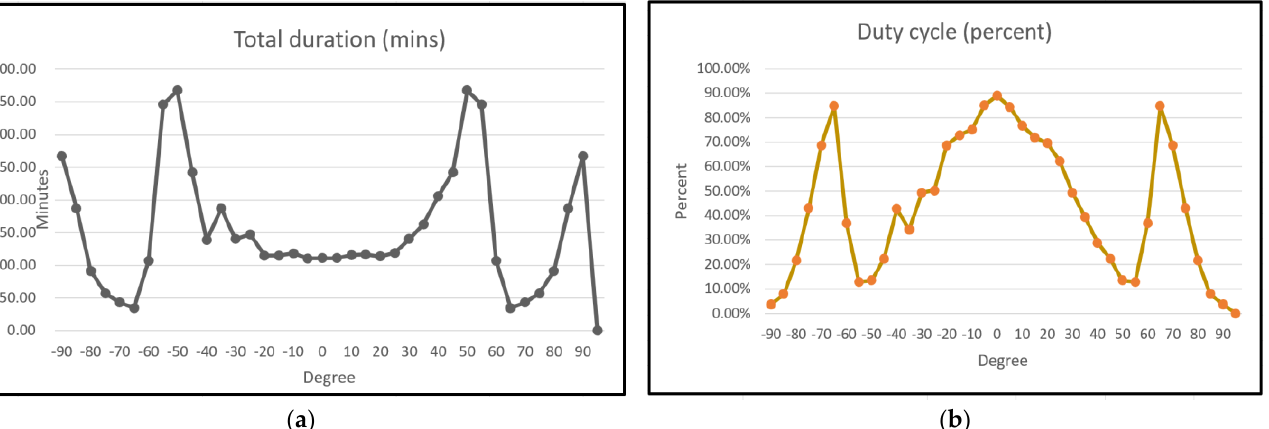
Figure 14. Satellite-to-ground duration analysis: ( a ) The total durations for different latitudes; ( b ) The duty cycle for different latitudes.